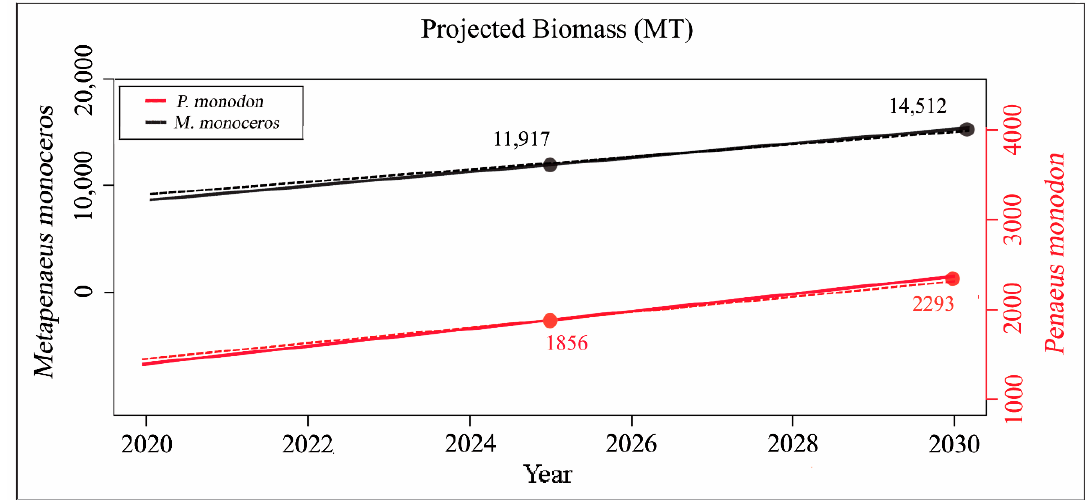
Figure 8. Biomass projections for both Penaeus monodon and Metapenaeus monoceros in metric tons (MT). Dots indicate the B MSY for the respective years.